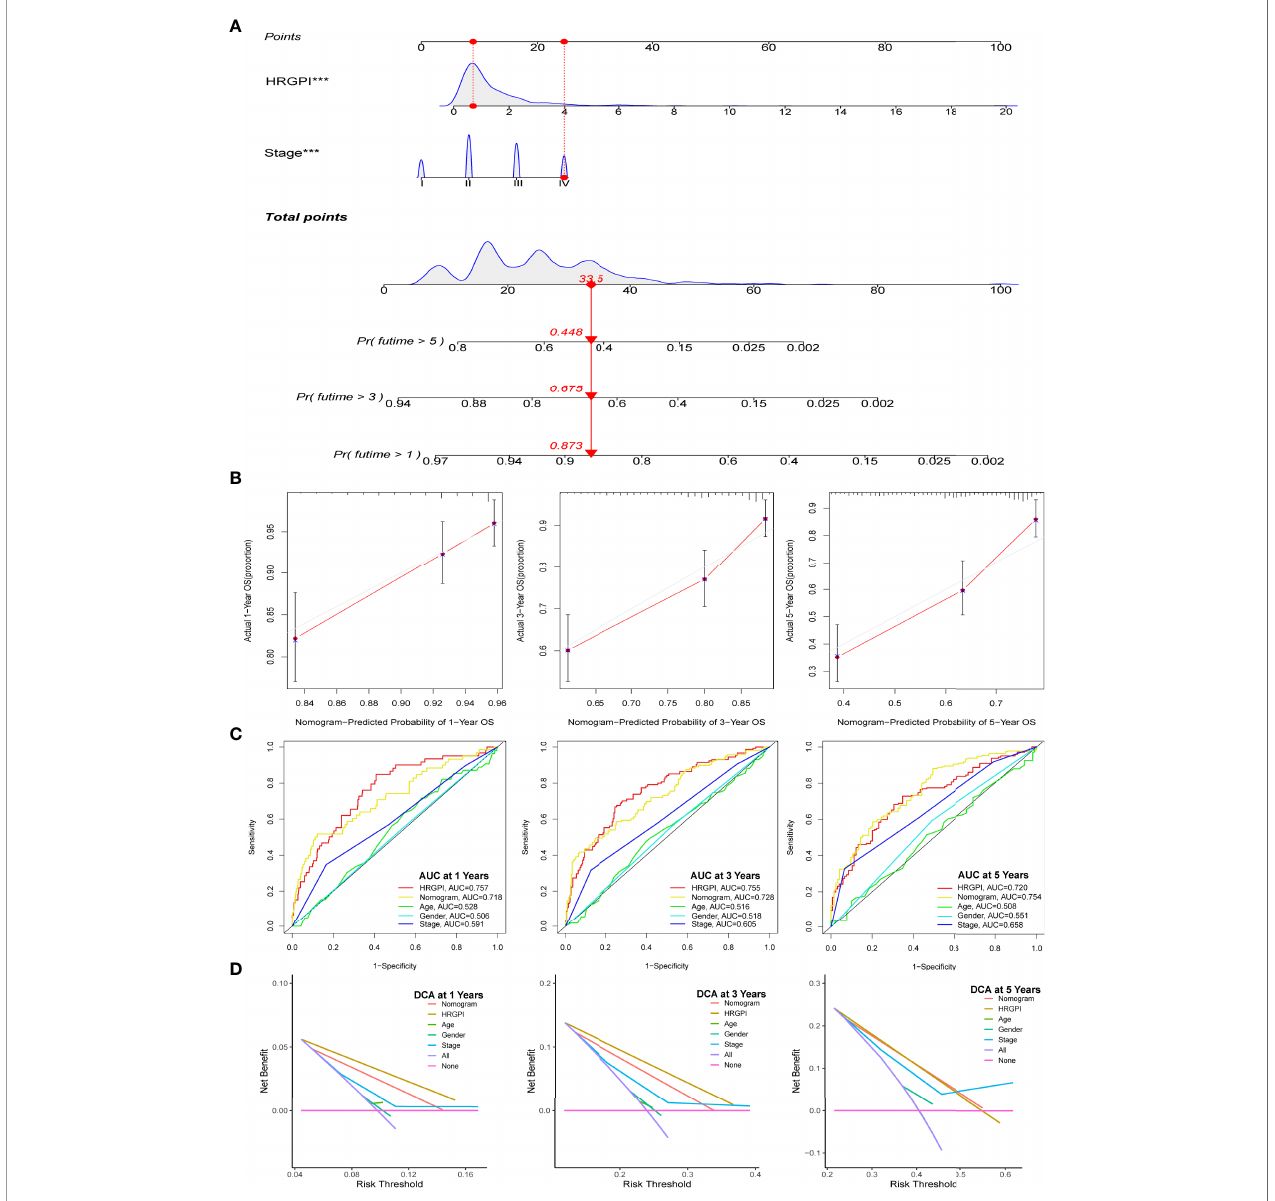
FIGURE 5 | Construction and validation of a nomogram containing HRGPI. (A) A nomogram to predict the 1-, 3-, and 5-year OS. (B) Calibration curves for the nomogram model. (C) ROC curves for the 1-, 3-, and 5-year OS. (D) DCA curves for the 1-, 3-, and 5-year OS. ( p < 0.05 *; p < 0.01 **; p < 0.001